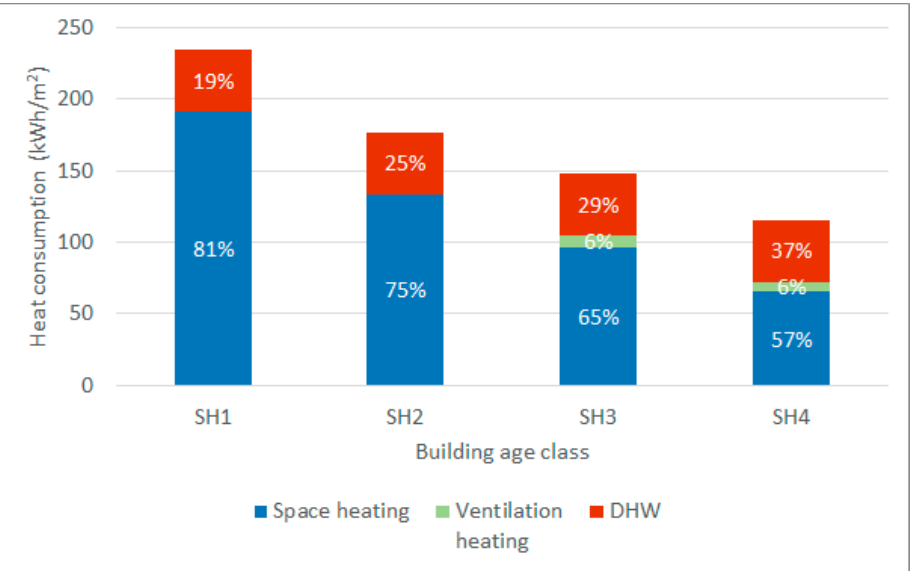
Figure 5. Specific heating demand in the reference buildings.